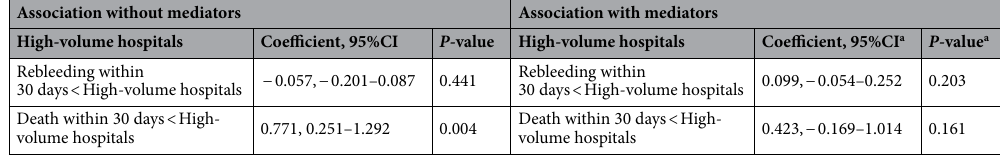
Table 5. Association of hospital characteristics with rebleeding and death within 30 days by using generalized structural equation model (GSEM). a Computed tomography used as a first-line diagnostic modality, early colonoscopy, and endoscopic therapies were included as the mediators in the generalized structural equation model (GSEM). The differences between coefficients with and without mediators were larger on death within 30 days. A two-tailed P-value < 0.05 was considered to indicate statistical significance. CI confidence interval.